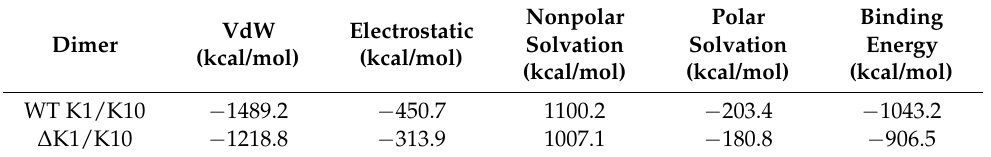
Table 1. Results of the MM/GBSA analyses performed for the WT and ∆ K1/K10 dimers. Binding Polar Nonpolar VdW Electrostatic Energy Solvation Solvation Dimer (kcal/mol) (kcal/mol) (kcal/mol) (kcal/mol) (kcal/mol) WT K1/K10 − 1489.2 − 450.7 1100.2 − 203.4 − 1043.2 ∆ K1/K10 − 1218.8 − 313.9 1007.1 − 180.8 −